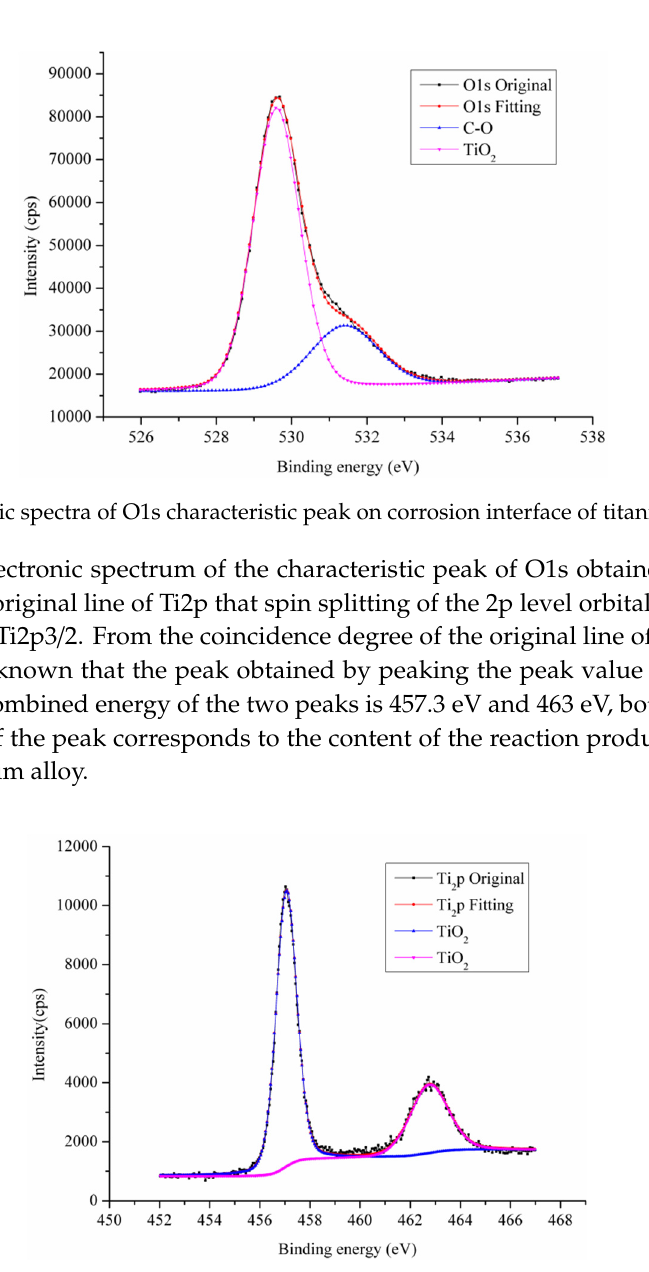
Figure 9. Electronic spectra of Ti2p characteristic peak on corrosion interface of titanium alloy in air.